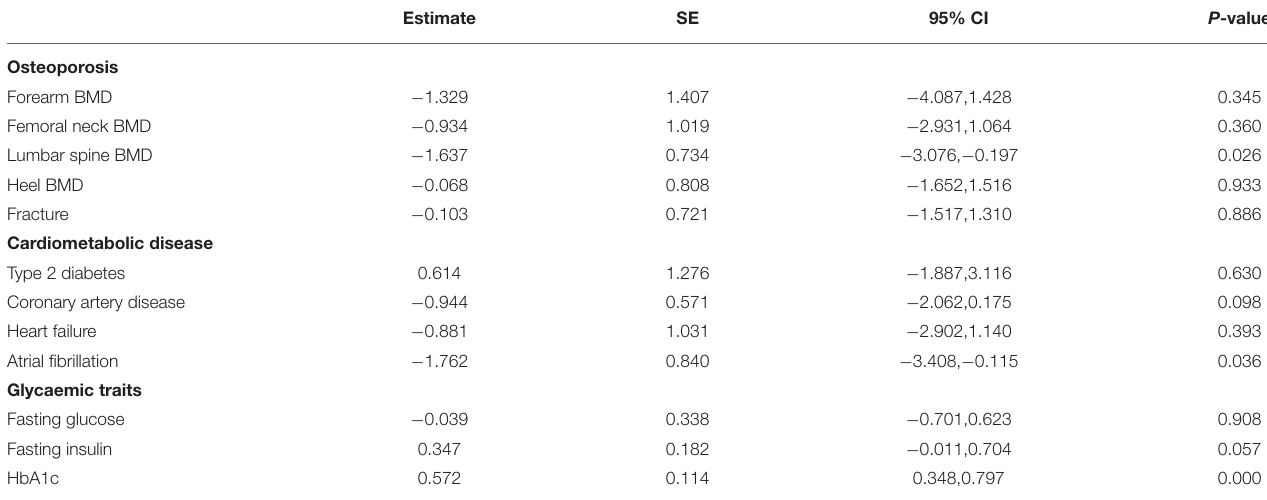
TABLE 5 | Mendelian randomization estimates between serum magnesium and outcomes after excluding potentially pleiotropic variants: rs11144134, rs448378. Estimate